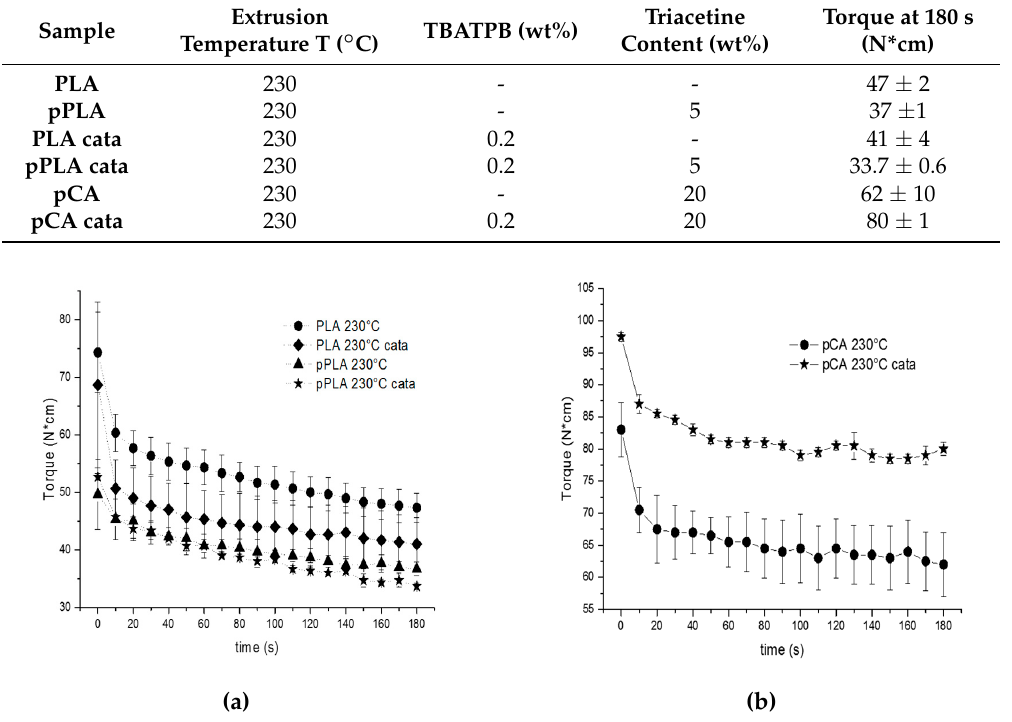
Figure 3. Torque as a function of time: ( a ) for the blends prepared with pure PLA-based samples; ( b ) for the blends prepared with pCA-based samples. N*cm = N·cm.